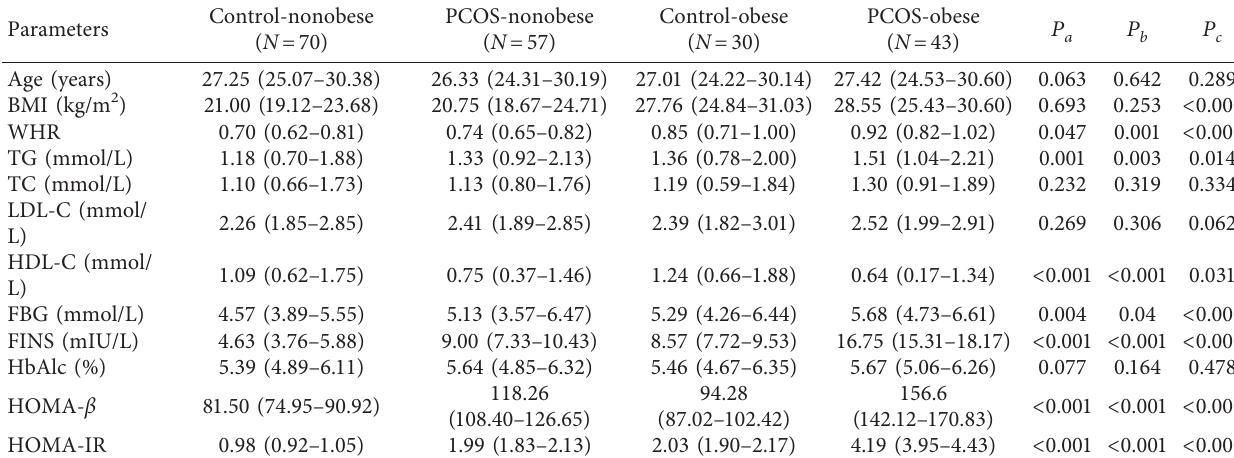
Table 2: Comparative analysis of the clinical data between PCOS patients and healthy controls.